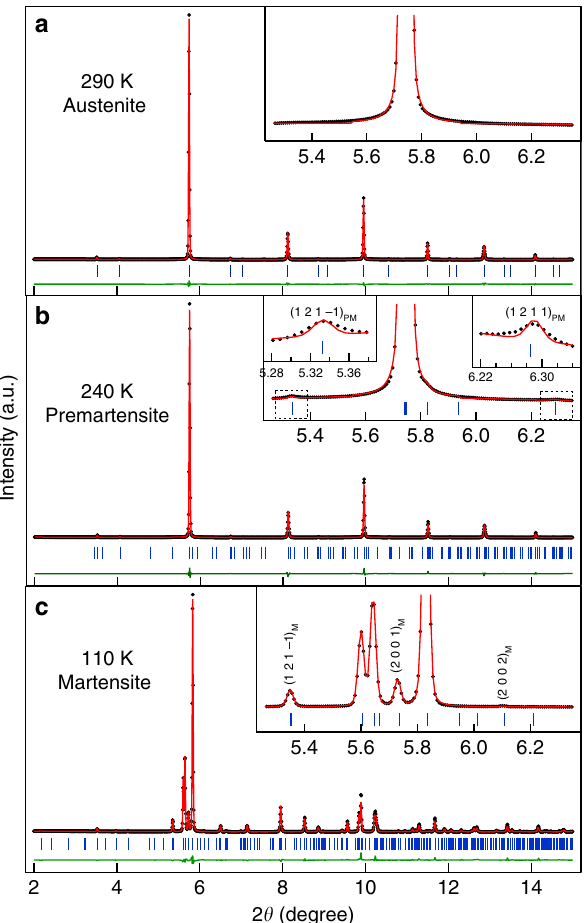
Fig. 3 Rietveld fi ts for the synchrotron X-ray powder diffraction patterns of Ni 1.9 Pt 0.1 MnGa. Rietveld re fi nements at a 290 K (cubic austenite phase), b 240 K (premartensite phase), and c 110 K (martensite phase). The experimental data, fi tted curve, and the residue are shown by circles (black), red continuous line, and green continuous line, respectively. The tick marks (blue) represent the Bragg peak positions. The insets show the fi t for the main peak region on an expanded scale. Satellite re fl ections in the premartensite (PM) and martensite phases (M) are shown by ( hklm ) PM and ( hklm ) M ,